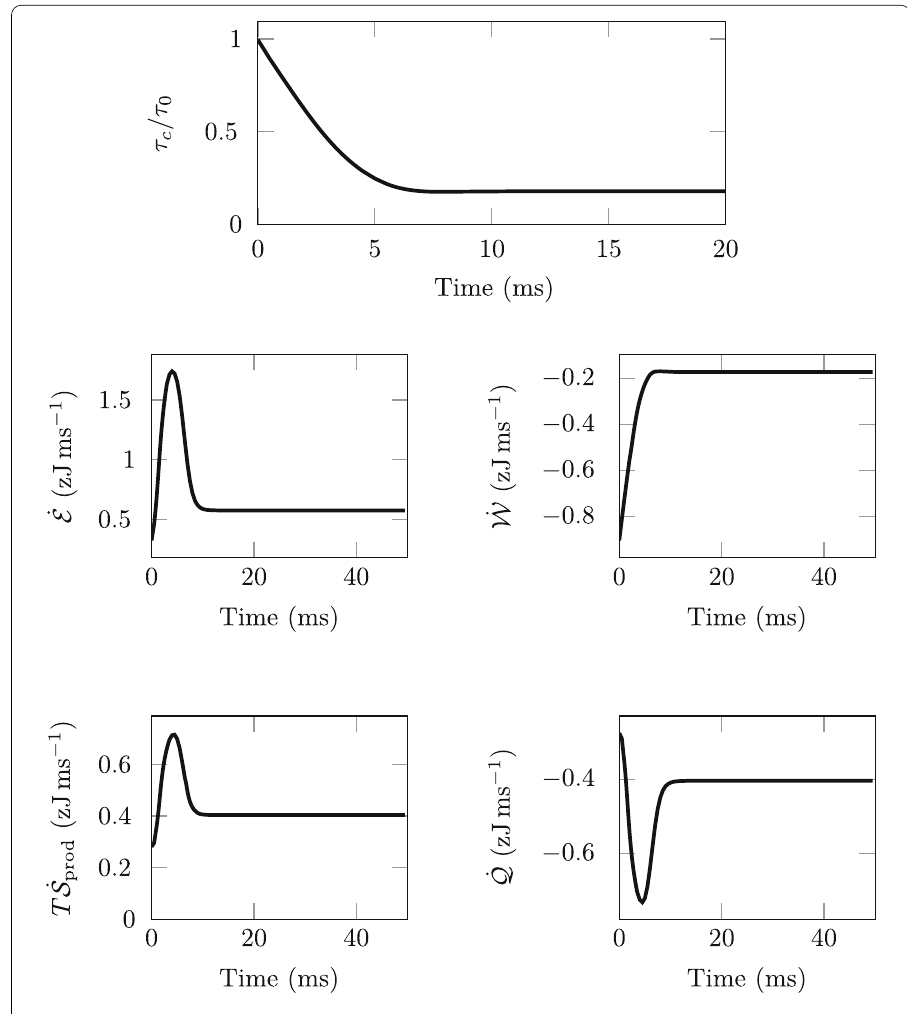
Fig. 10 Average tension and thermodynamic fluxes per myosin head for constant shortening velocity simulation with the Huxley’57 model. The isometric tension is denoted by τ 0